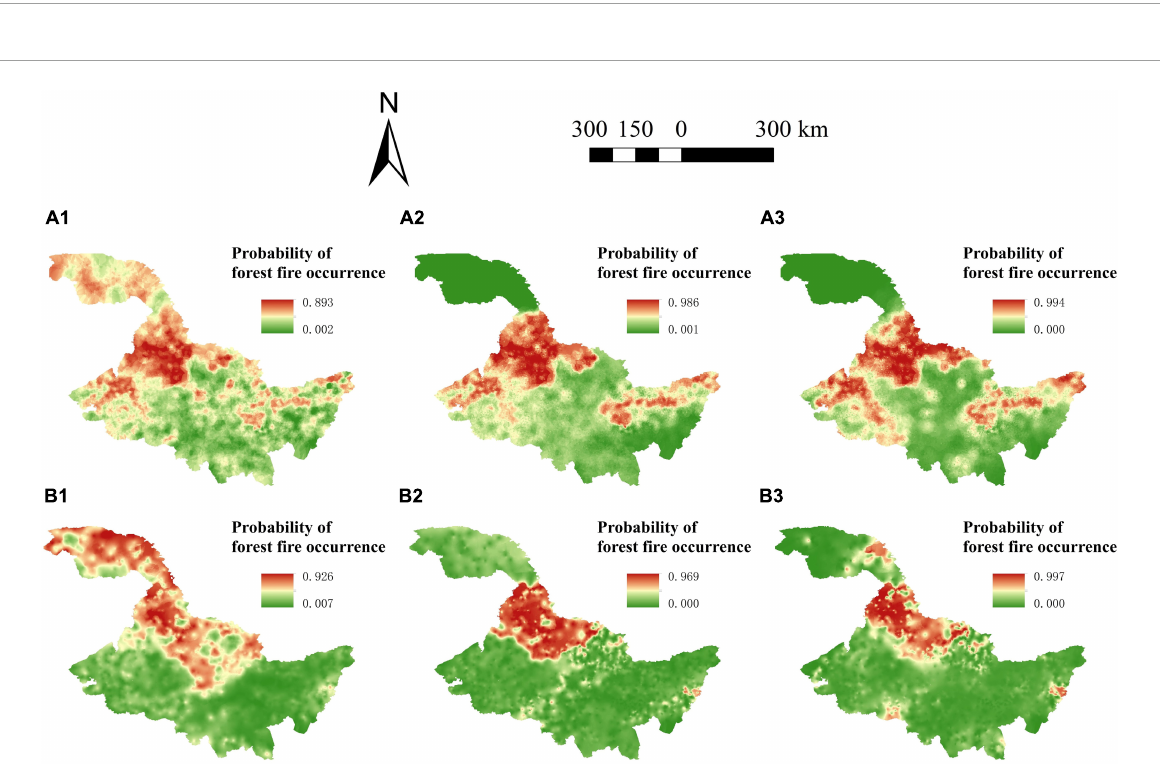
FIGURE7 Spatial variation of forest fire probability in Heilongjiang Province, China. (A1) Forest fire probabilities predicted by the logistic regression (LR) model in spring fire prevention period. (A2) Forest fire probabilities predicted by the mixed LR model in spring fire prevention period. (A3) Forest fire probabilities predicted by the geographically weighted logistic regression (GWLR) model in spring fire prevention period. (B1) Forest fire probabilities predicted by the LR model in autumn fire prevention period. (B2) Forest fire probabilities predicted by the mixed LR model in autumn fire prevention period. (B3) Forest fire probabilities predicted by the GWLR model in autumn fire prevention